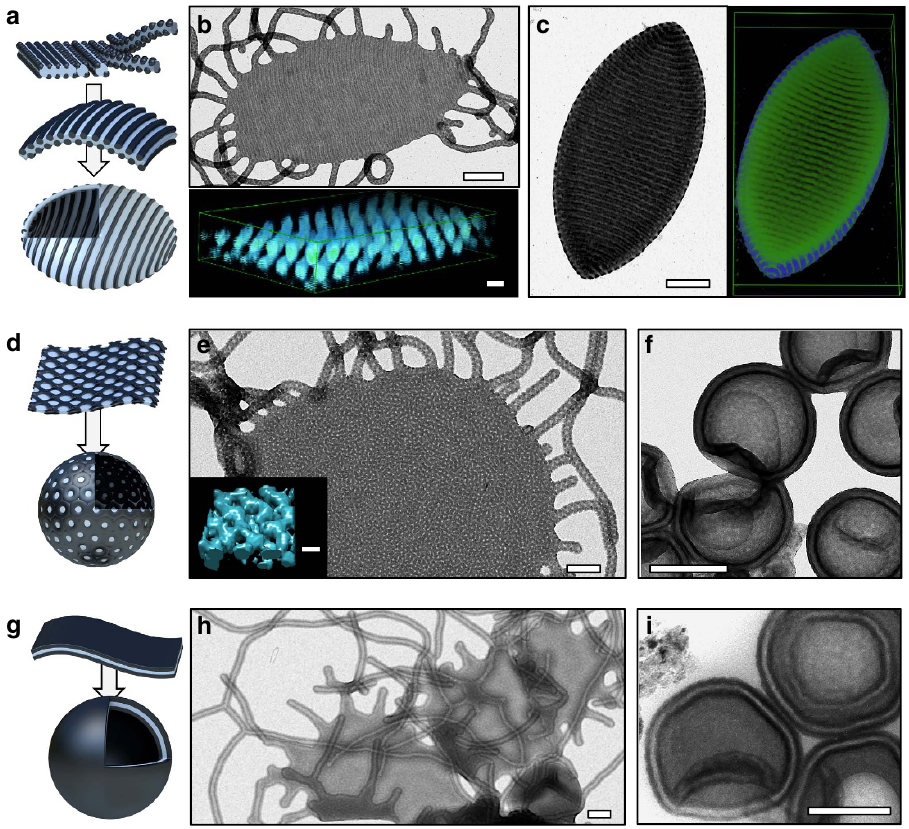
Figure 4 | Polymer sheets and vesicles with defined patch morphology. Samples were prepared from acetone/isopropanol mixtures unless otherwise noted. ( a ) Schematic of spheres-on-cylinders that transform to cylinders-on-bilayer sheets/vesicles. ( b ) TEM image of cylinder-on-sheet of S 510 B 539 T 154 (75:25v/v), and tomographic reconstruction of PB patches on top and bottom of the PS sheet (PB cyan, PS omitted). ( c ) TEM and tomographic reconstruction of a ‘lemon’-shaped vesicle of S 510 B 539 T 154 with PB cylinders on in- and outside of the PS membrane after ageing (85:15v/v). ( d ) Schematic of sheet and vesicles with bicontinuous membrane. ( e ) TEM and tomographic reconstruction of PB network within the PS sheet of S 307 B 530 T 75 (60:40v/v) (PB cyan, PS omitted). ( f ) Fully evolved vesicle with bicontinuous membrane of S 307 B 530 T 63 on ageing (60:40v/v). ( g ) Schematic of the core–shell sheets and (lamellar) vesicle. ( h ) TEM image of a core–shell sheet of S 300 B 756 T 56 ( n -hexane/isopropanol 50:50v/v) and ( i ) core–shell (lamellar) vesicle